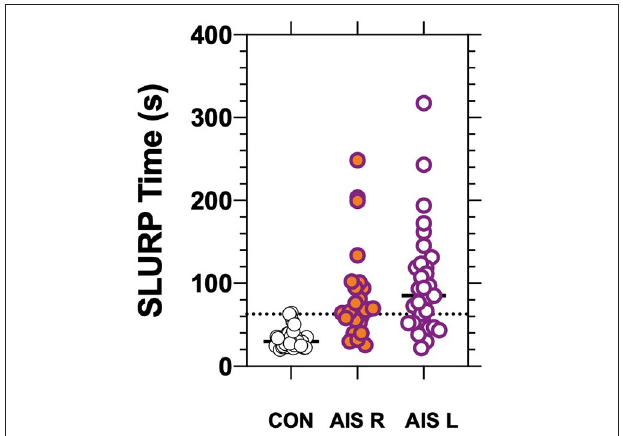
FIGURE 3 | Eye-hand coordination time for controls and AIS patients having Right ( p < 0.01) or Left ( p < 0.01) hemisphere lesions as confirmed radiologically. The bars show group/individual tracing time and the horizontal dotted line indicates the 97.5th percentile for control.